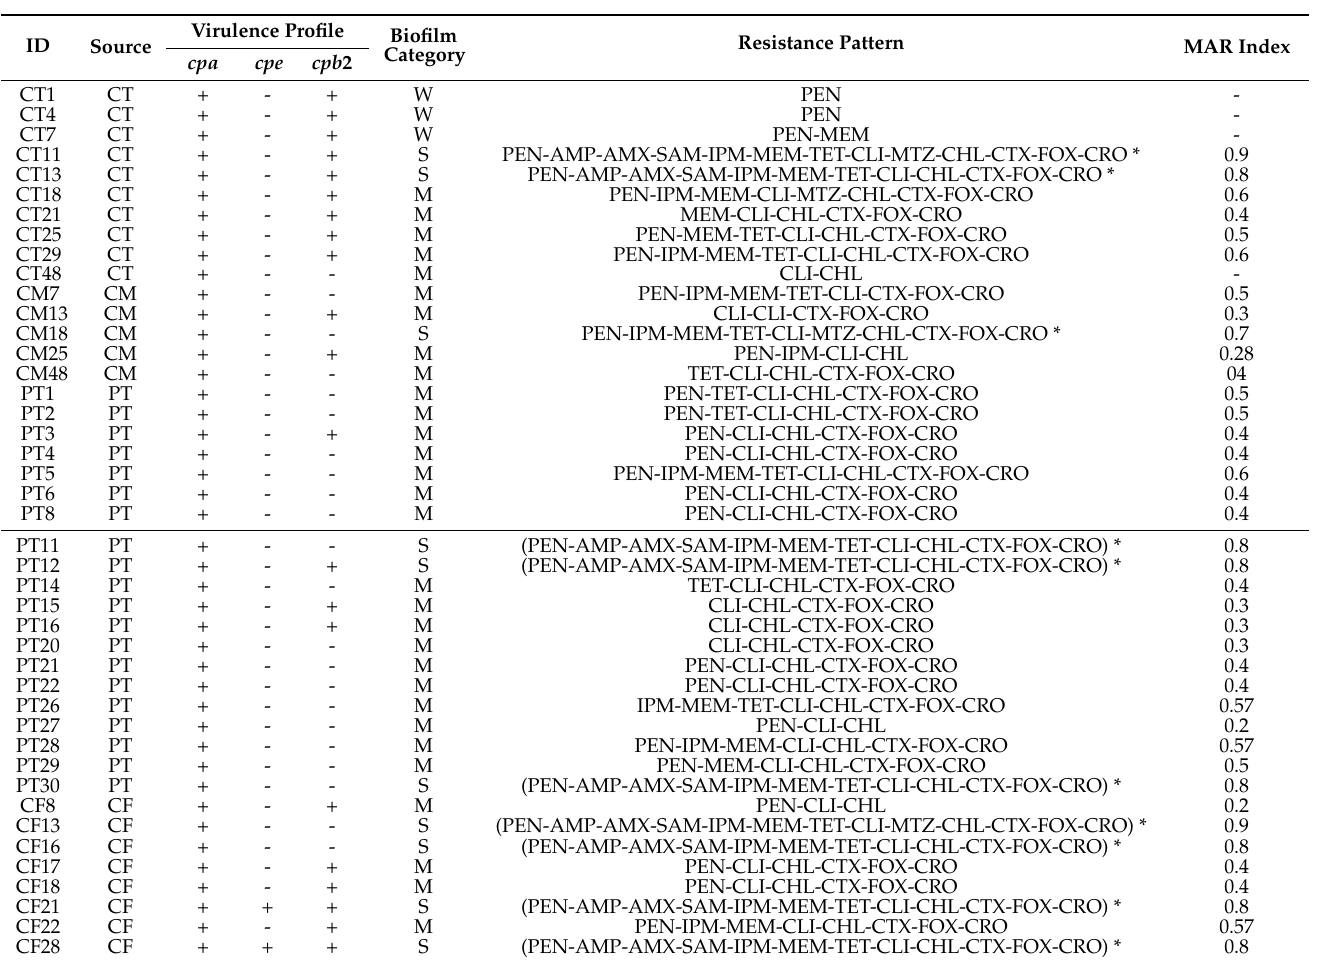
Table 3. Toxin type, biofilm category, and antimicrobial resistance profiles of 50 Clostridium perfringens isolates from chicken, pigeons, camels, and human